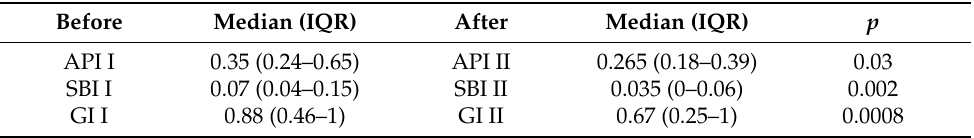
Table 3. Comparison of clinical indicators of periodontal status before and after the application of the toothpaste. The Wilcoxon signed-rank test.